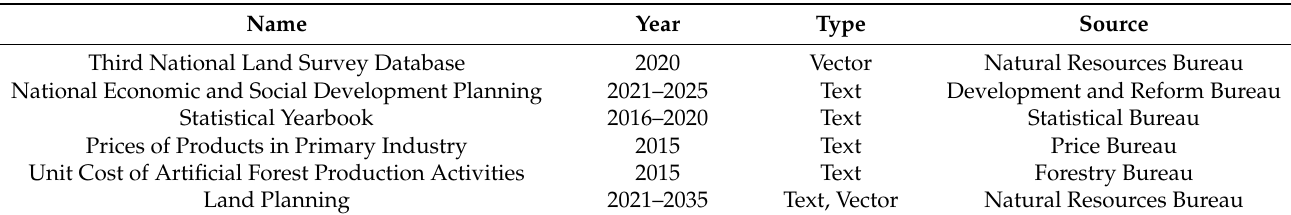
Table 5. Data for the case